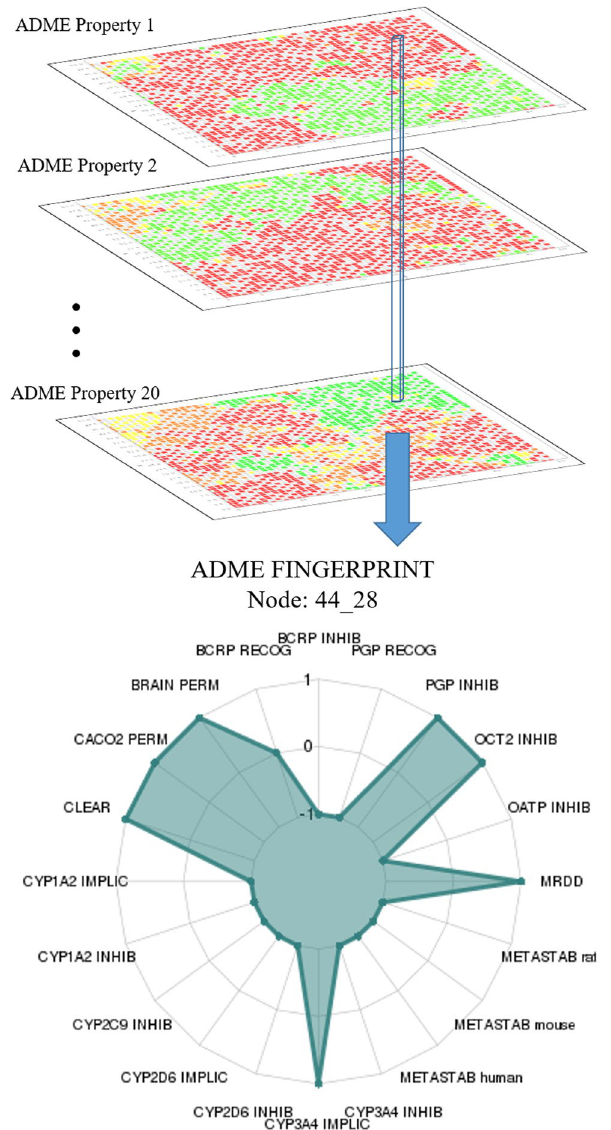
Figure 2. ADME fingerprint for the node 44_28. The multilayer representation of the ADME-Space (top) allows the comparison of the maps for more properties. The ADME fingerprint of a single node is the vector that goes through the maps for all the properties. It can be represented with a unique diagram (bottom), because for the given node the three values allowed correspond to the external circle ( + 1), the internal circle (0), and the central point ( −